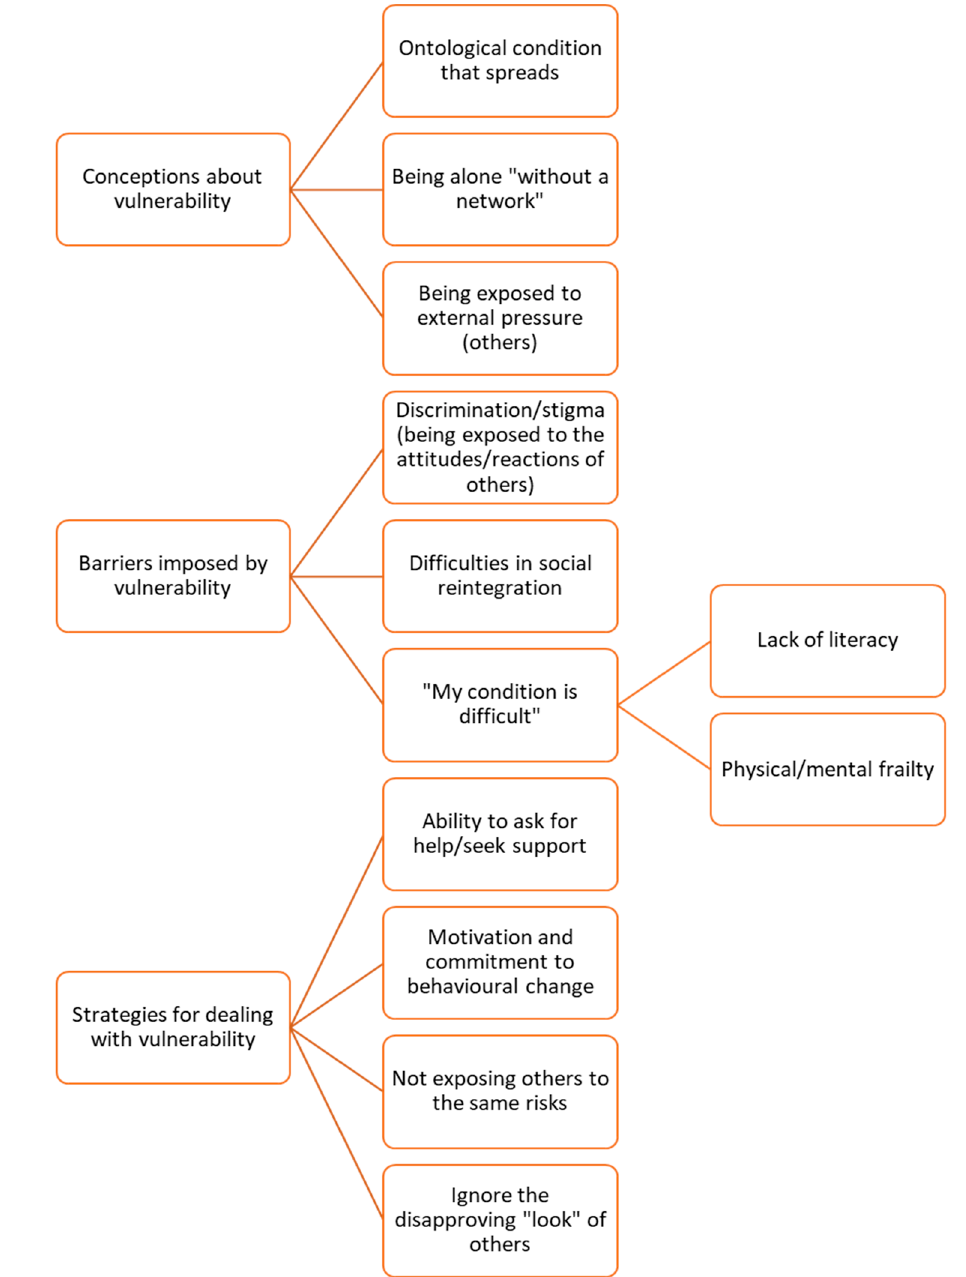
Figure 1. Thematic map of themes and subthemes. Another frequent theme in this dimension was being alone “without a network”.